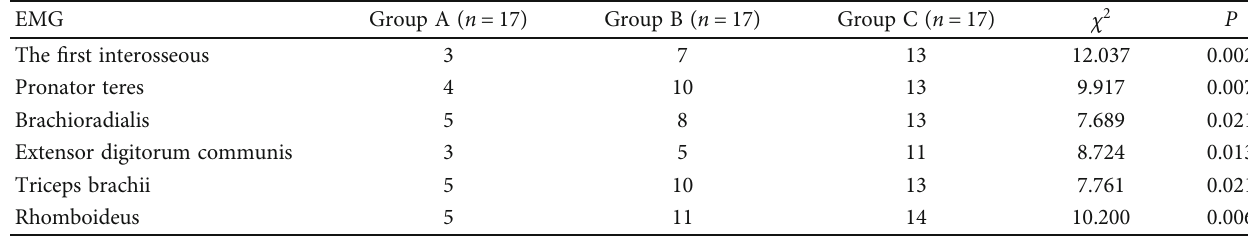
Table 2: Comparison of detection results of EMG ( n ).